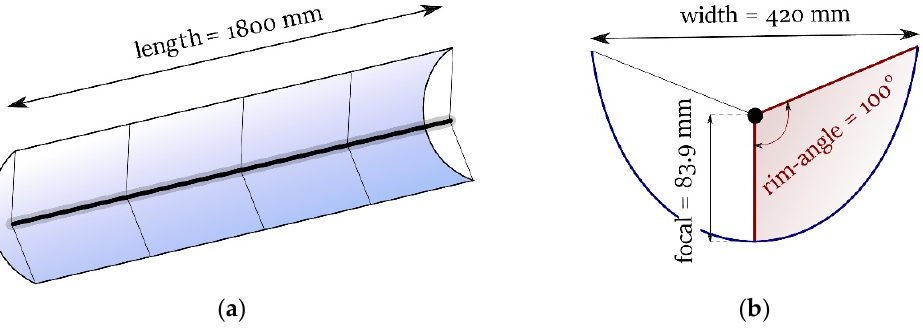
Figure 1. Sketch of the micro-parabolic trough collector (m-PTC). ( a ) 3D view of the parabolic mirror. ( b ) Profile of the m-PTC. ( b ) Profile of the